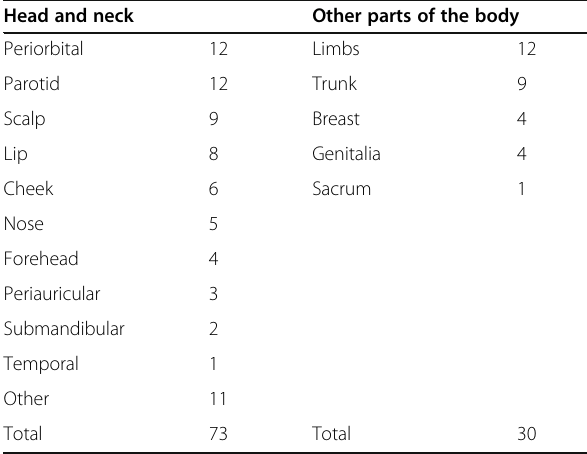
Table 1 The distribution of infantile haemangioma through different parts of the body among cases included in the study Head and